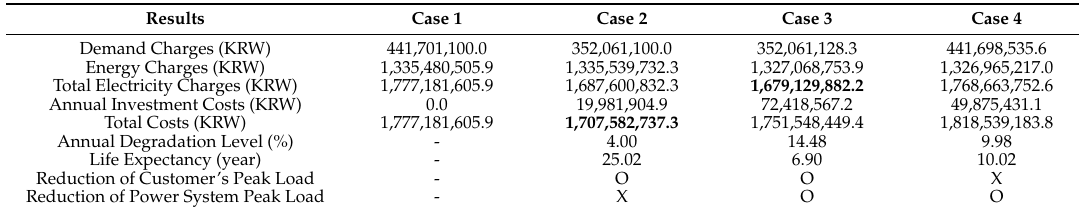
Table 3. Results by BESS operation strategy.